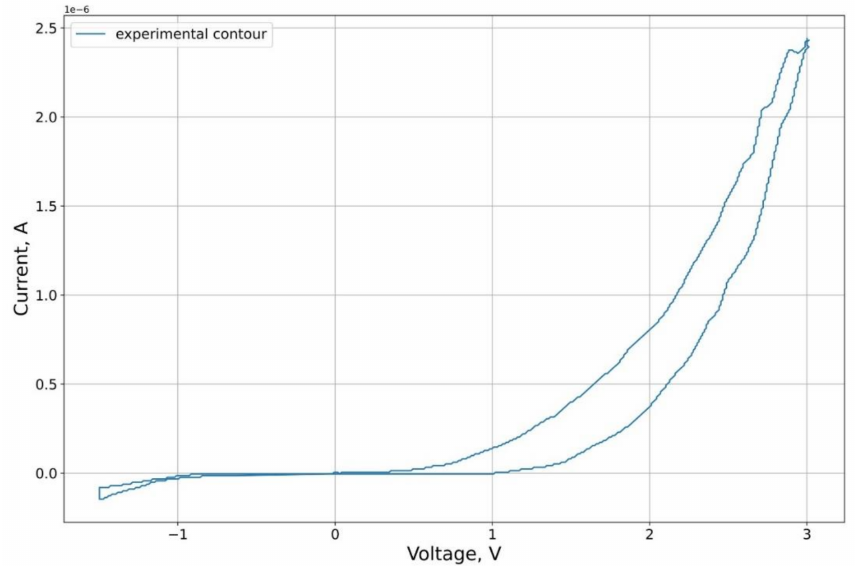
Figure 4. Schematic representation of the investigated structure and its volt–ampere characteristic.